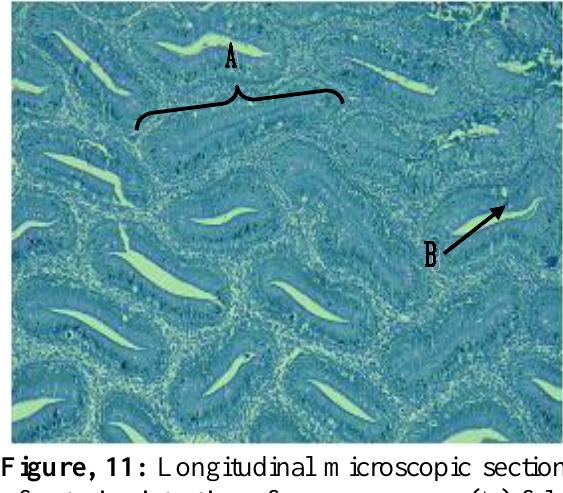
Figure, 11: Longitudinal microscopic section of anterior intestine of common carp, (A) fold (B)goblet cell (arrow), PAS with AB ph2.5 stain (X100).